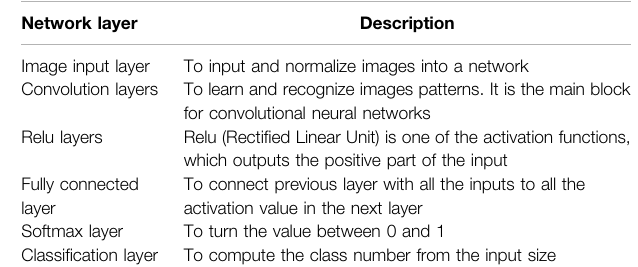
TABLE 1 | Descriptions of network